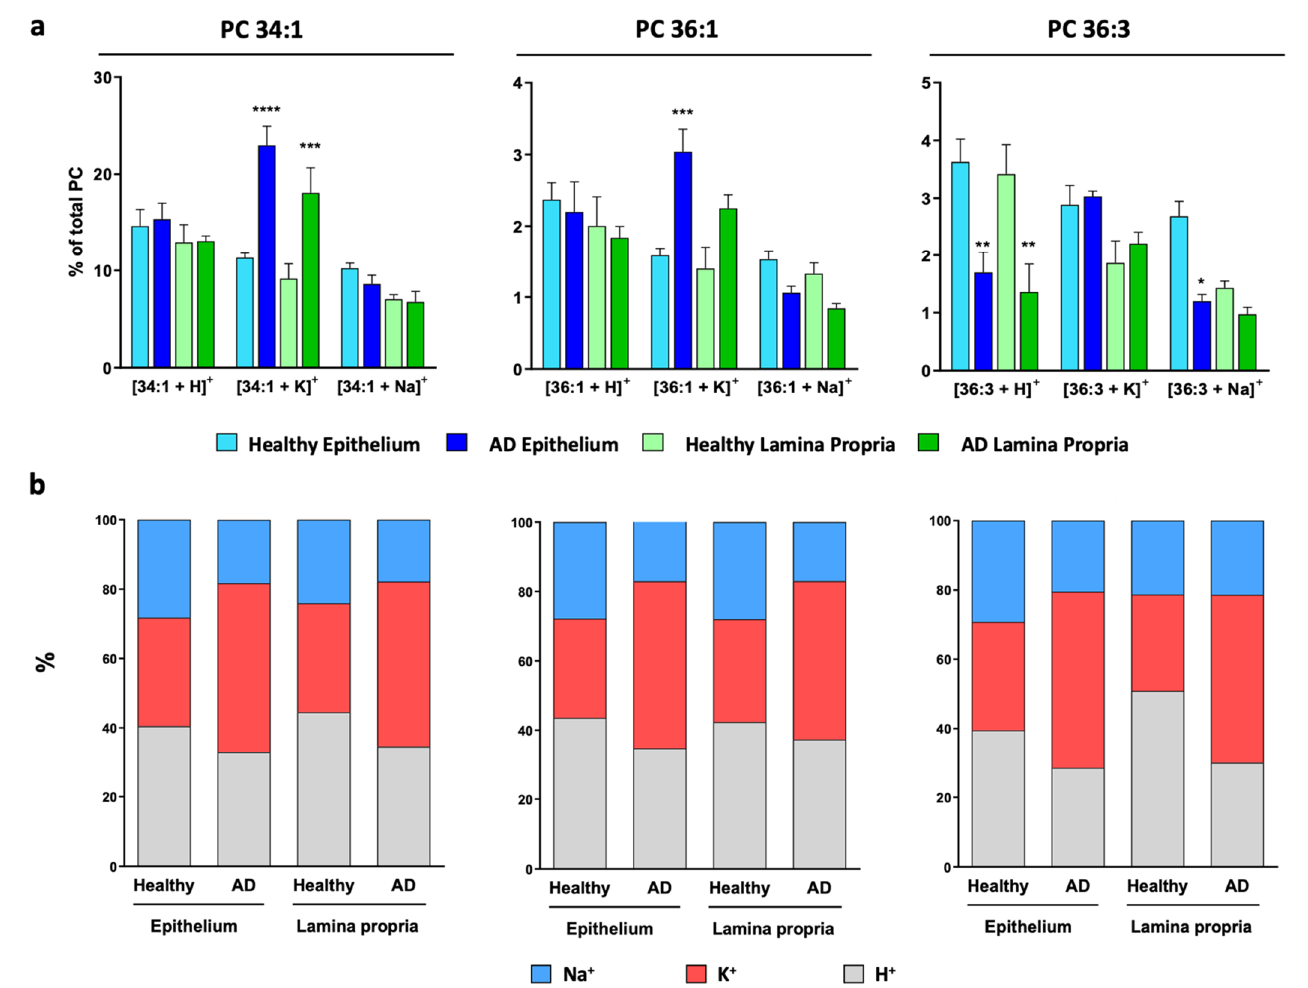
Figure 4. Homogenous impact of tumorigenesis on K + PC adducts. ( a ) Levels of lipid adducts of selected lipid species PC 34:1, PC 36:1, and PC 36:3 in healthy and AD mucosa (the rest of the species may be found in Figure S5). Values are expressed as mean +/− SEM, n = 4–5. Adenomatous and healthy tissue were compared using paired or unpaired Student’s t -test. * p < 0.05; ** p < 0.01; *** p < 0.001; **** p < 0.0001. These species were chosen depending on the impact that malignization had on the total species levels. Thus, PC 34:1, PC 36:1, and PC 36:3 levels increased, remained unaltered, or decreased, respectively, in AD mucosa compared to the healthy epithelium [19]. The rest of the species (PC 34:2, PC 36:2, and PC 36:4) may be found in Figure S5. ( b ) Normalized values showing that despite the impact of tissue malignization on the total levels of a particular lipid species, the level of the potassium adduct was always increased in the adenomatous counterpart.